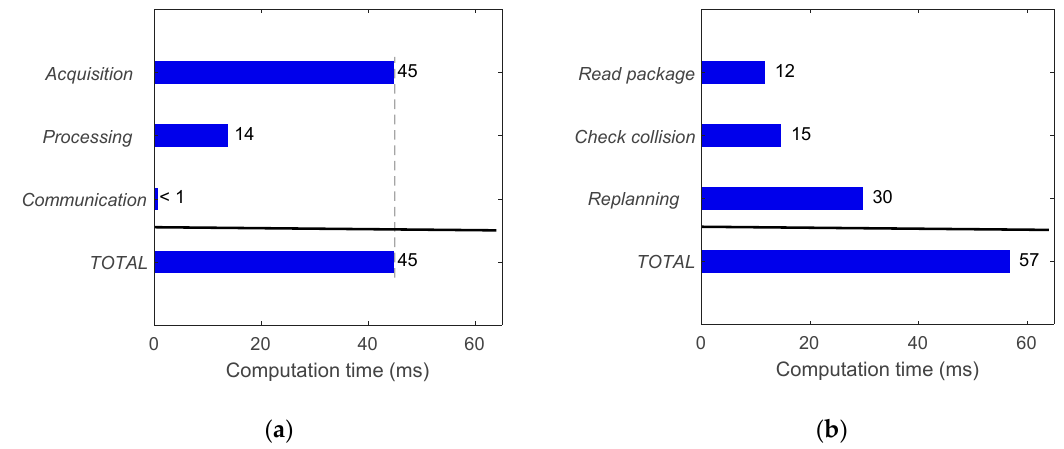
Figure 19. Approximated average computation times for: ( a ) Machine vision module with acquisition, image processing and communication stages running simultaneously (times do not accumulate); ( b ) Path planning module with read package, check collision and re-planning stages running in cascade, where the total time is the sum of the three stages.